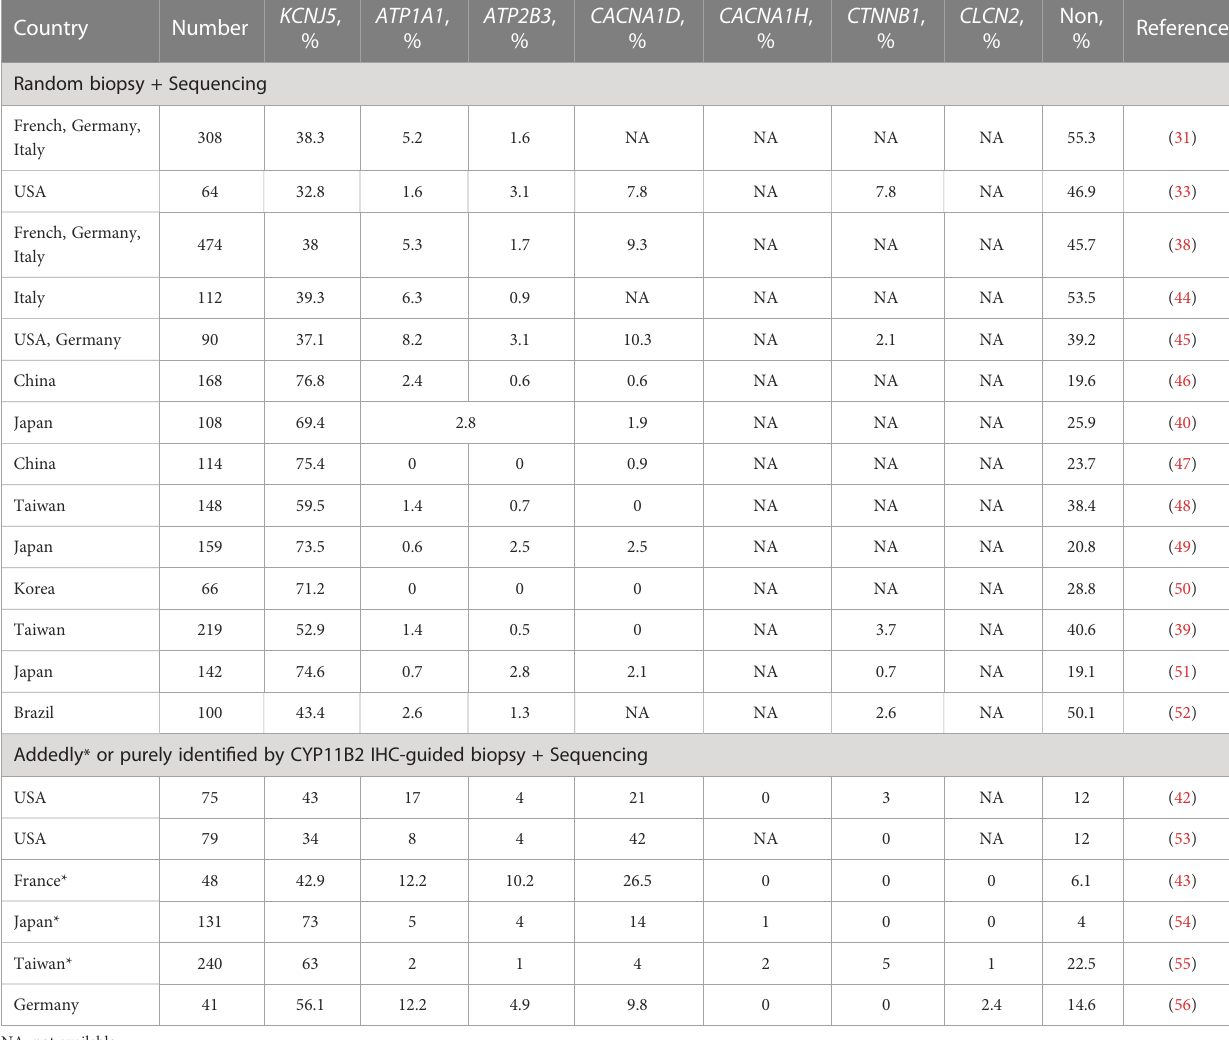
TABLE 1 The detection rats of various somatic mutations in different countries dependent on traditional random biopsy or CYP11B2-IHC staining guided biopsy.